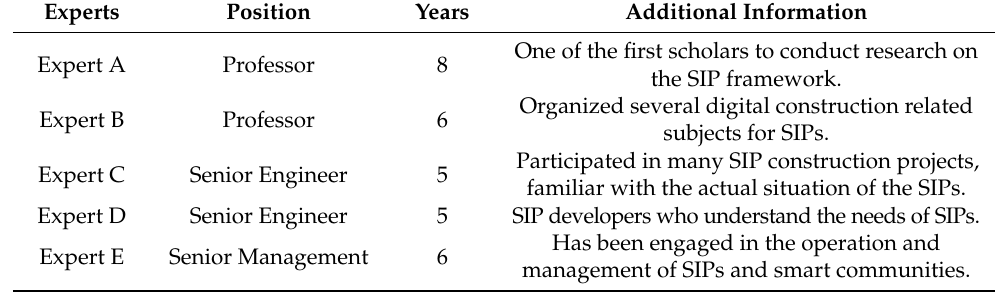
Table 2. Composition of experts.